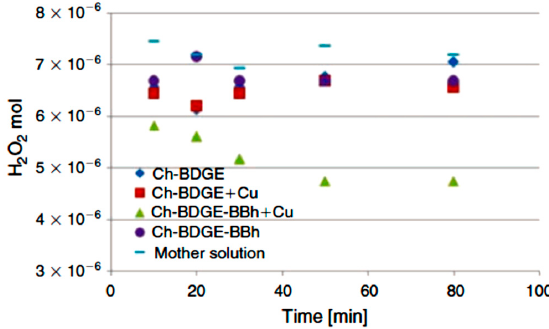
Figure 6. Reaction of hydrogen peroxide. Reproduced from Ana Agustina Aldana et al. [14].